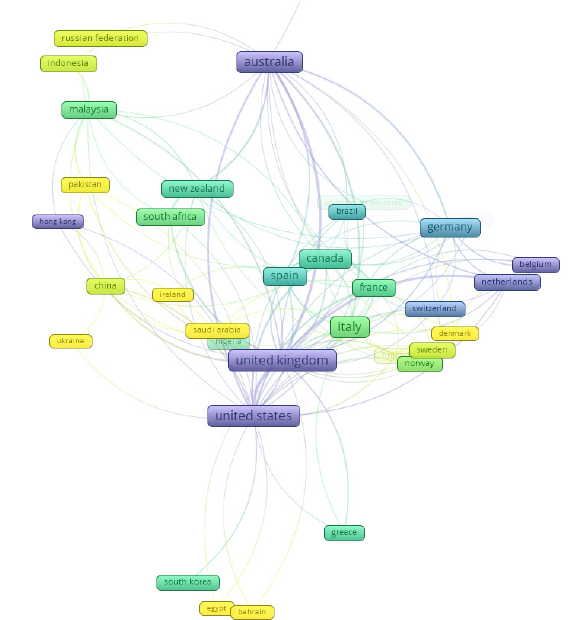
Figure 5. Spatial component of the bibliometric